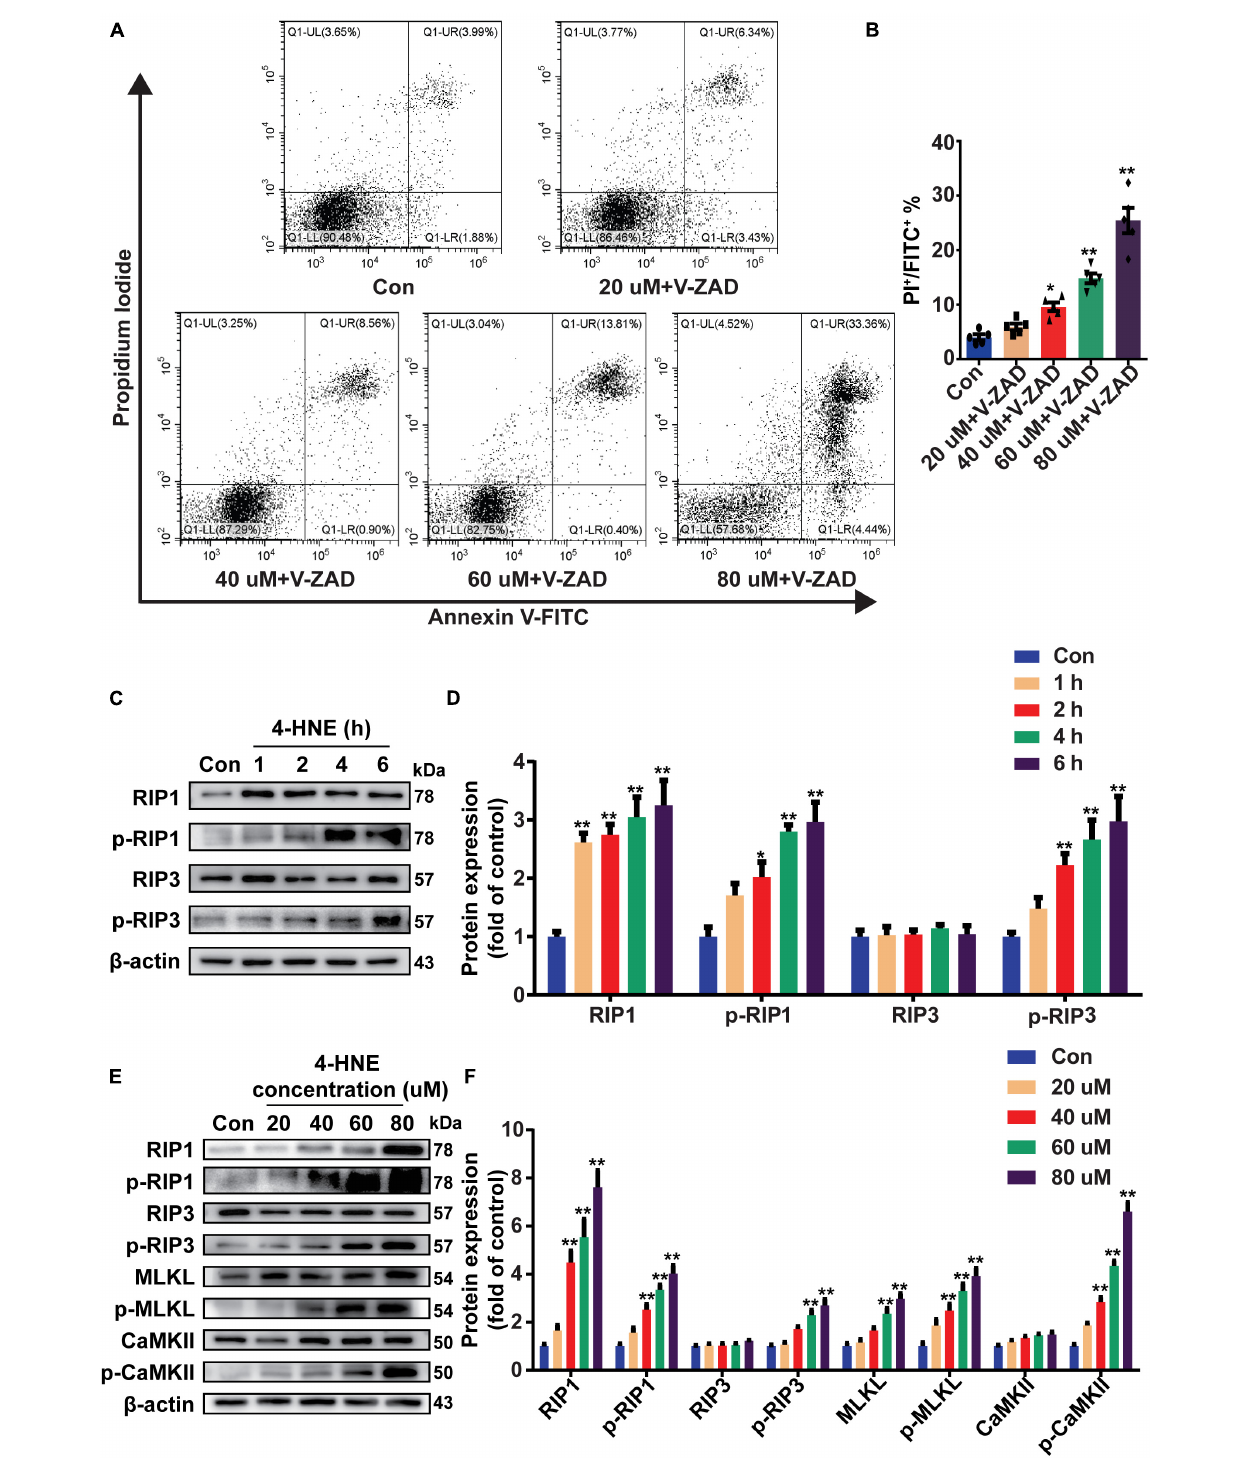
FIGURE 4 | 4-Hydroxy-2-non-enal induces cell necroptosis in H9c2 cells. (A,B) Necroptotic cells were determined using flow cytometry stained with Annexin V and propidium iodide (PI), and the cell necroptosis ratio was demonstrated as the percentage of Annexin V + /PI + cells ( n = 5). (C,D) Representative Western blots and relative expression of RIP1, p-RIP1, RIP3, and p-RIP3 under time gradients of 4-HNE treatment in H9c2 cells ( n = 5). (E,F) Representative immunoblots and relative expression of RIP1, p-RIP1, RIP3, p-RIP3, MLKL, p-MLKL, Ca 2 + /CaMKII, and p-CaMKII in H9c2 cells treated with different concentrations of 4-HNE ( n = 5). * p < 0.05 vs. control group, ** p < 0.01 vs. control group.